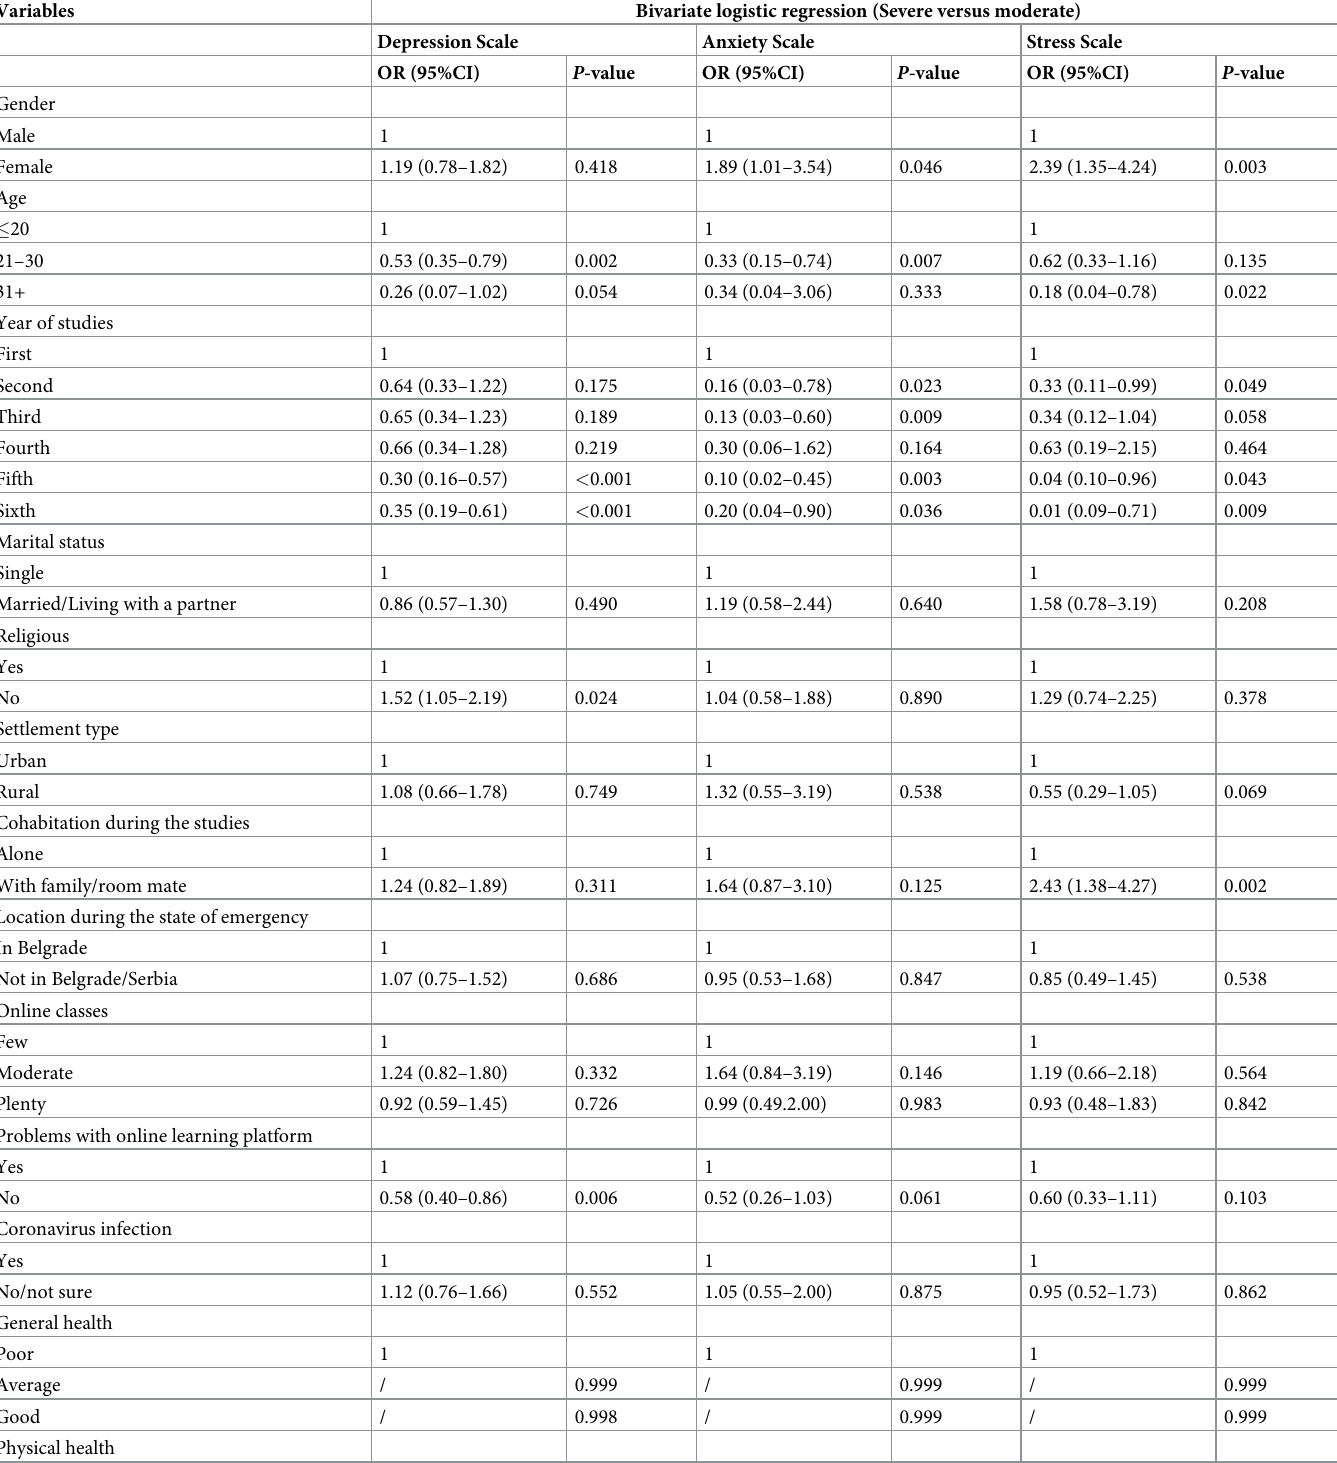
Table 3. Associations of scales of depression, anxiety and stress with students’ demographic variables, their medical studies and health status during the coronavi- rus pandemic–results of bivariate logistic